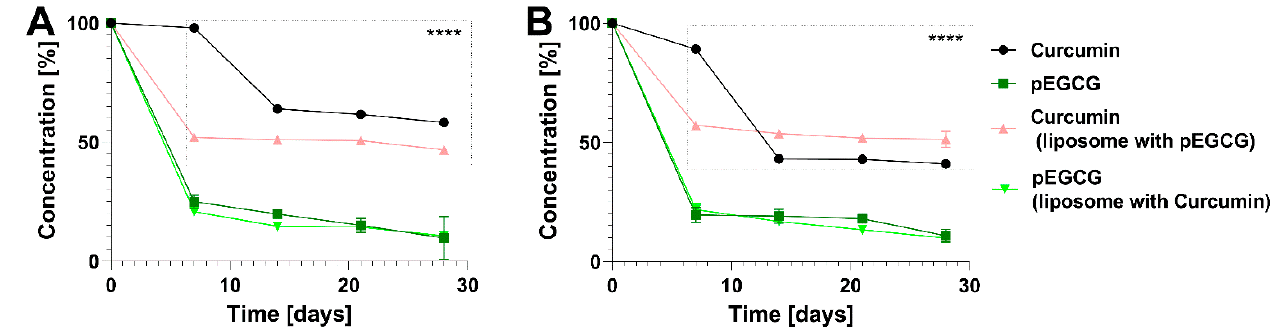
Figure 5. Stability study of CUR, pEGCG and their combination in liposomal nanoformulations at: ( A ) room temperature (20 ◦ C), and ( B ) refrigerator temperature (4–8 ◦ C). Statistical significance was assessed by Tukey’s Test (**** p < 0.0001). Error bars represent standard deviations of the mean. Table 3. Changes in the concentration of CUR and pEGCG in liposomal nanoformulations in the stability study in room temperature (20 ◦ C).